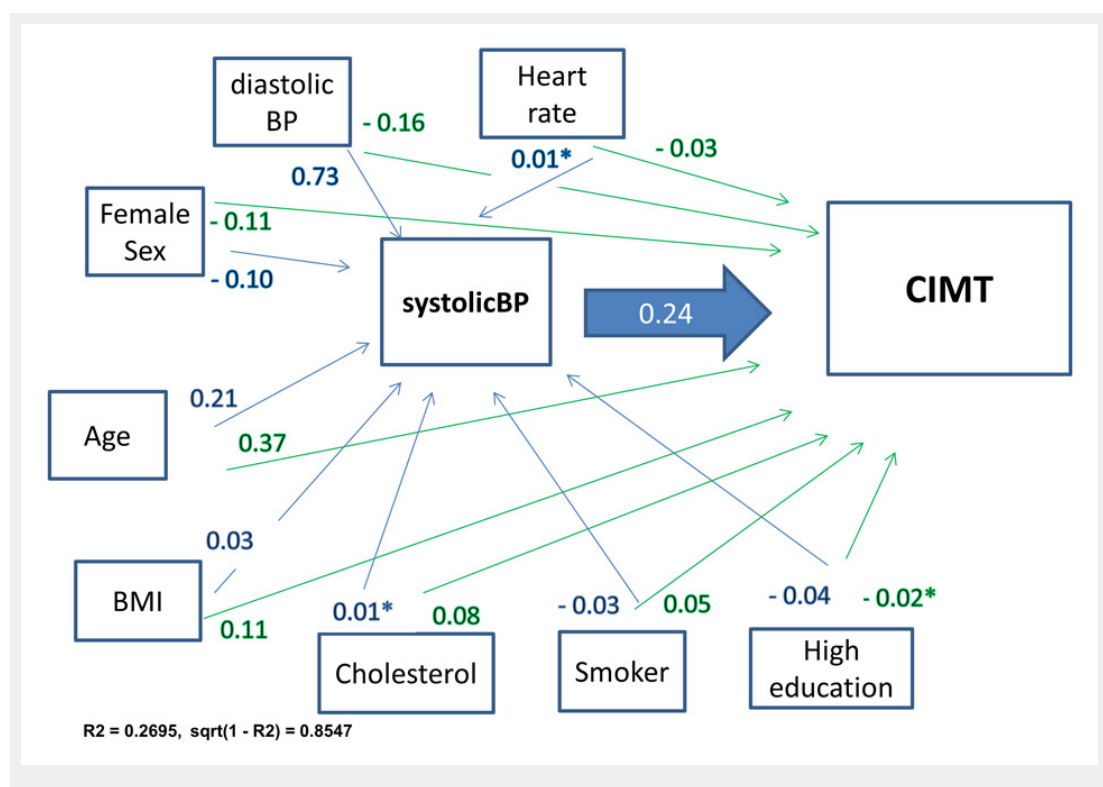
Figure 4 Path analyses: systolic blood pressure and carotid intima media thickness. Beta coefficients in blue: direct effect on systolic BP, in green: indirect effect on CIMT, mutually adjusted and adjusted for physical activity (non- significant impact on BP and CIMT); R2 = variance explained by path model; sqrt(1–r2) = estimated